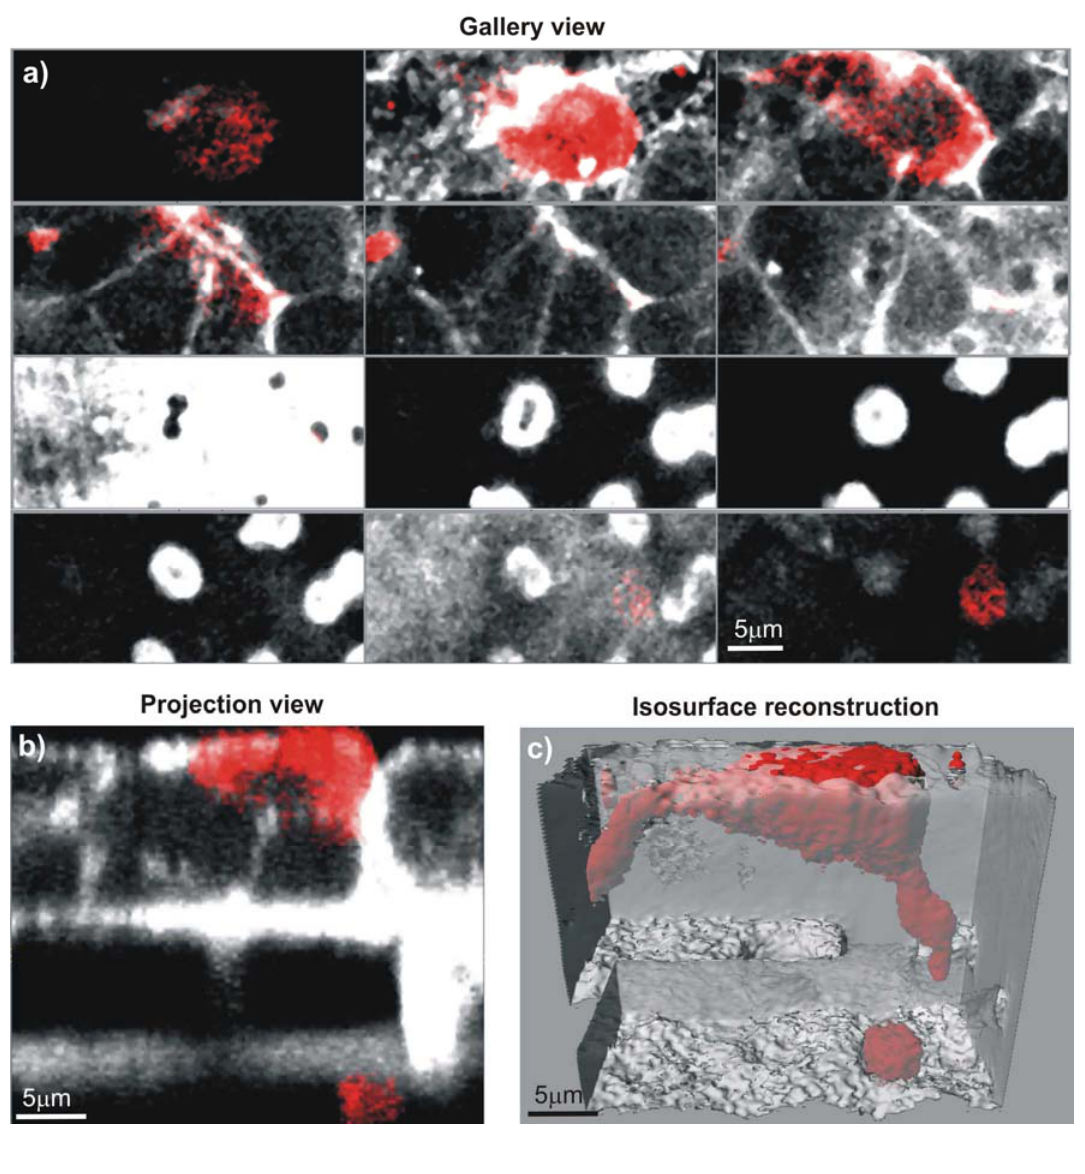
Figure 2 Visualisation modes of LSM 3D data stacks . Epithelial cells (16HBE14o-) and MDM were co-cultured, fixed and stained for F-actin (Phalloidin-rhodamine, white). Additionally, the MDM were stained for CD14, a specific surface marker (red). The cultures were observed with a Zeiss 510 Meta laser scanning microscope at a Z- interval of 0.3 μ m, resulting in total 70 layers. Various visualisation modes using the IMARIS software from Bitplane AG are presented to show the spatial arrangement of the MDM and the epithelial cells. a) Gallery view, showing every 8 th layer, b) Projection view across the xz-axes, c) an iso-surface rendering with a transparent